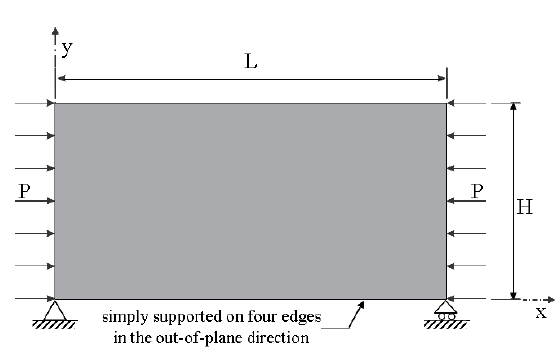
Figure 1. Rectangular solid plate subject to uniaxial compressive load.